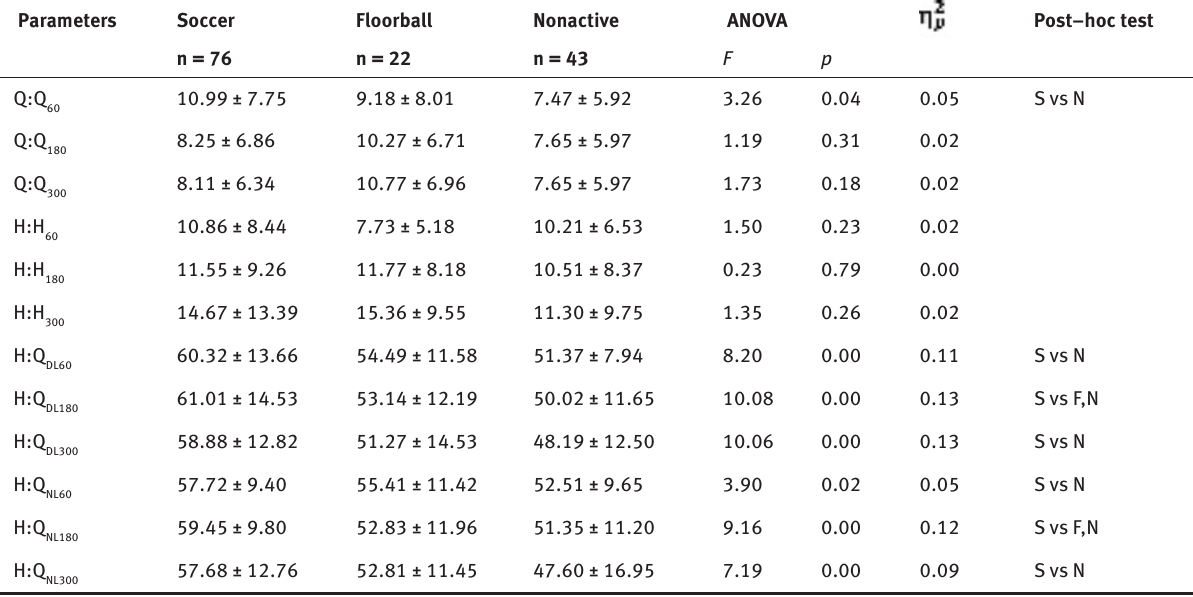
Table 4: Bilateral and ipsilateral strength differences (%) of knee extensors and flexors with respect to different sport activities at different contraction velocities (60, 180, 300°s -1 ). Parameters